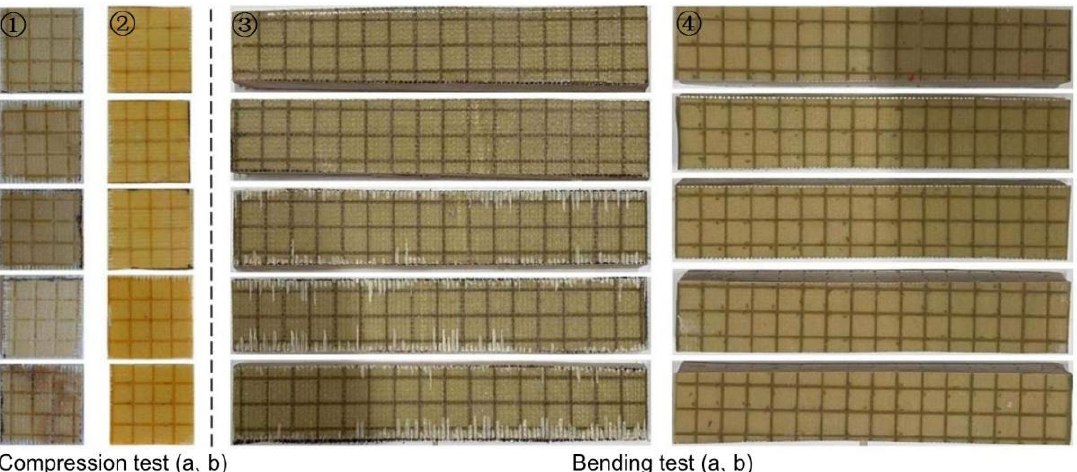
Figure 19. Five samples of flat compression and bending test, 1—compression test samples ( a ), 2—compression test samples ( b ), 3—bending test samples ( a ), and 4—bending test samples ( b ).